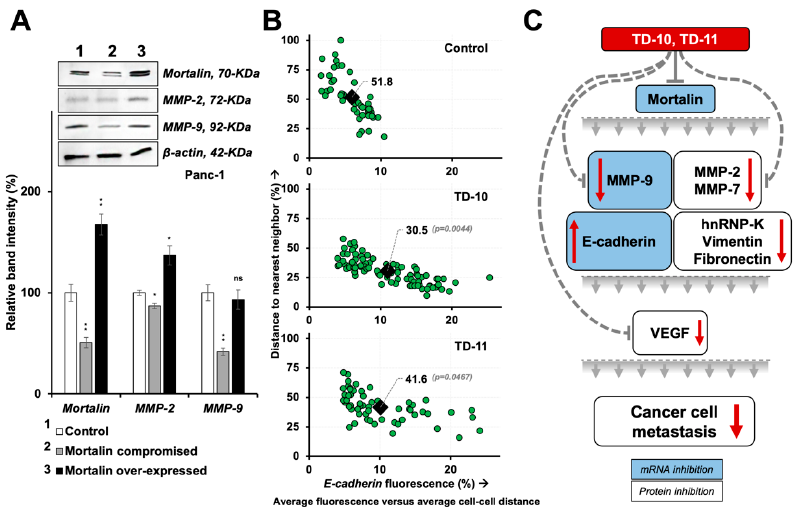
Figure 9. Dependency of EMT on mortalin expression and re-epithelization of the highly metastatic Panc-1 cells treated with TEG derivatives. ( A ) Western blotting and quantitation in mortalin- compromised and -over-expressed cells showed reduction and increase in MMP expression, respectively. ( B ) Cell congregation analyses showed that E-cadherin fluorescence had an inverse relation with the distance between the expressing cells and the TEG derivatives that caused the epithelial transformation of these cells. ( C ) Line diagram summarizing the mechanism of mortalin-dependent anti-metastasis activity of the TEG derivatives, TD-10 and TD-11. Transcriptional changes are highlighted in blue. Statistical significance was defined as p -values (*) where * < 0.05 and ** < 0.01 represent significant, very significant and highly significant, respectively.